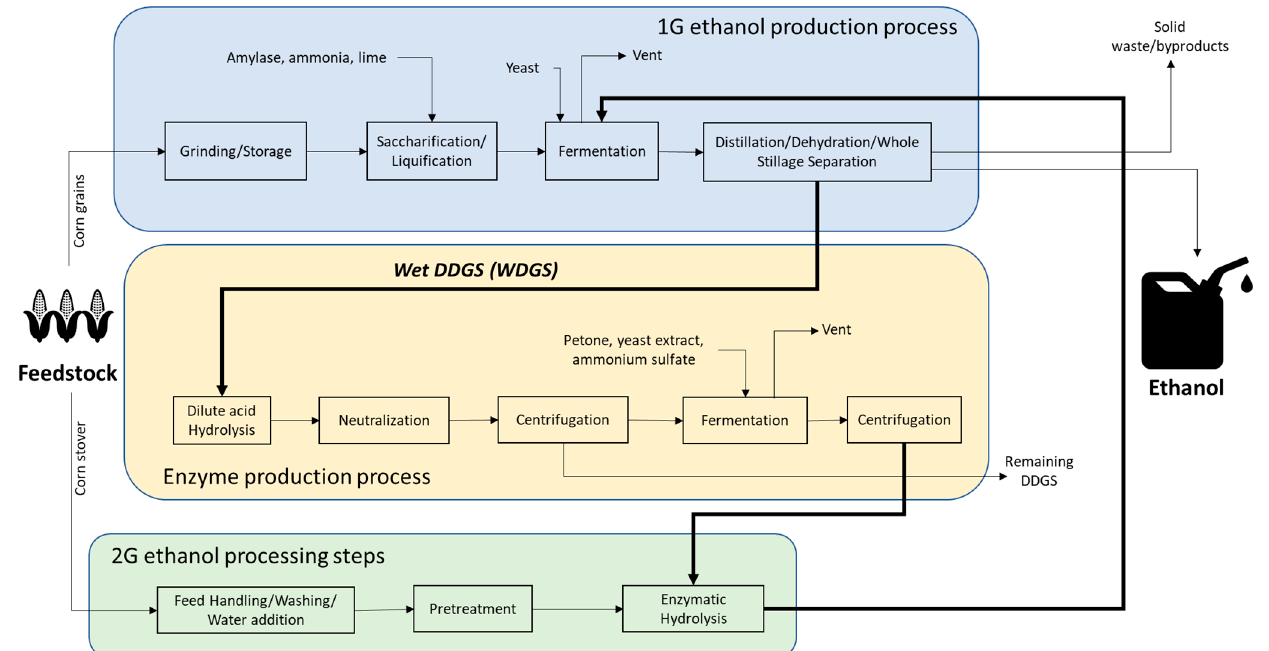
Figure 3. The integration of 1G and 2G ethanol via the production of lignocellulolytic enzymes using DDGS.